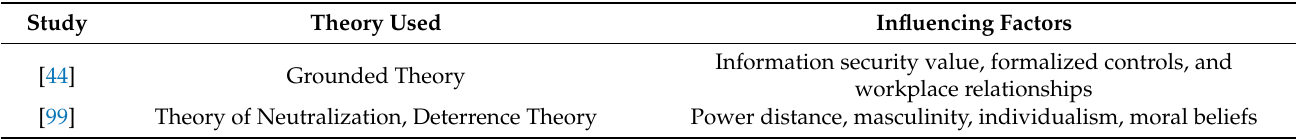
Table A1. Overview of factors influencing